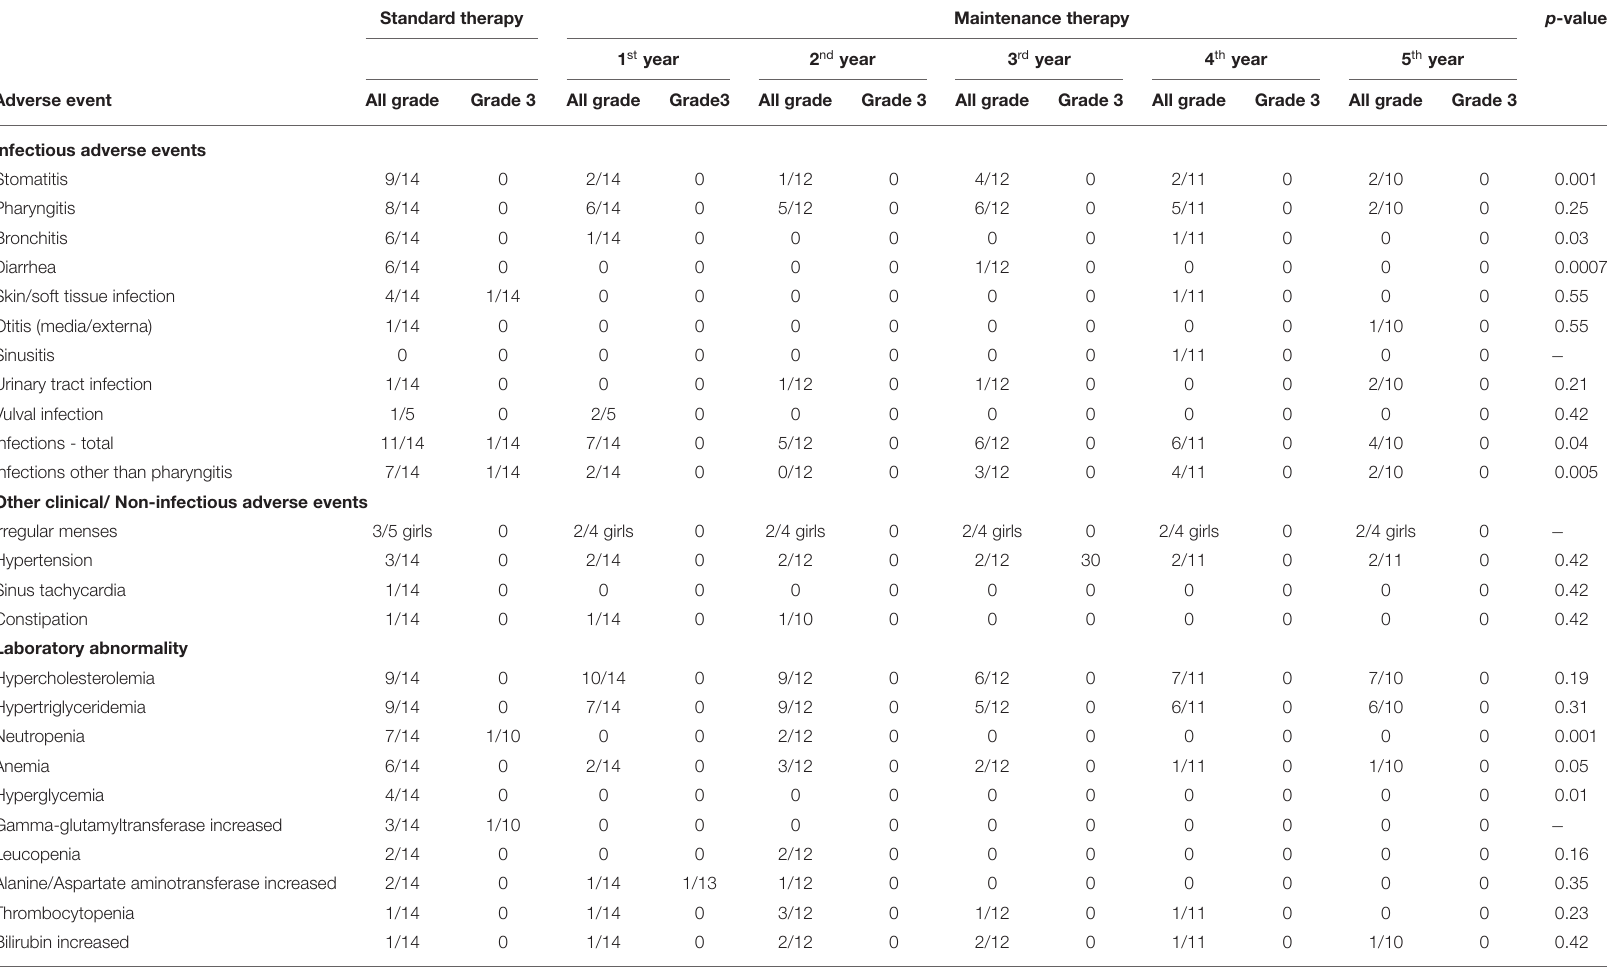
TABLE 3 | Adverse events related to everolimus in the study group during standard and maintenance therapy. NS, not statistically significant ( p > 0.05) in a two-tailed Fisher’s exact